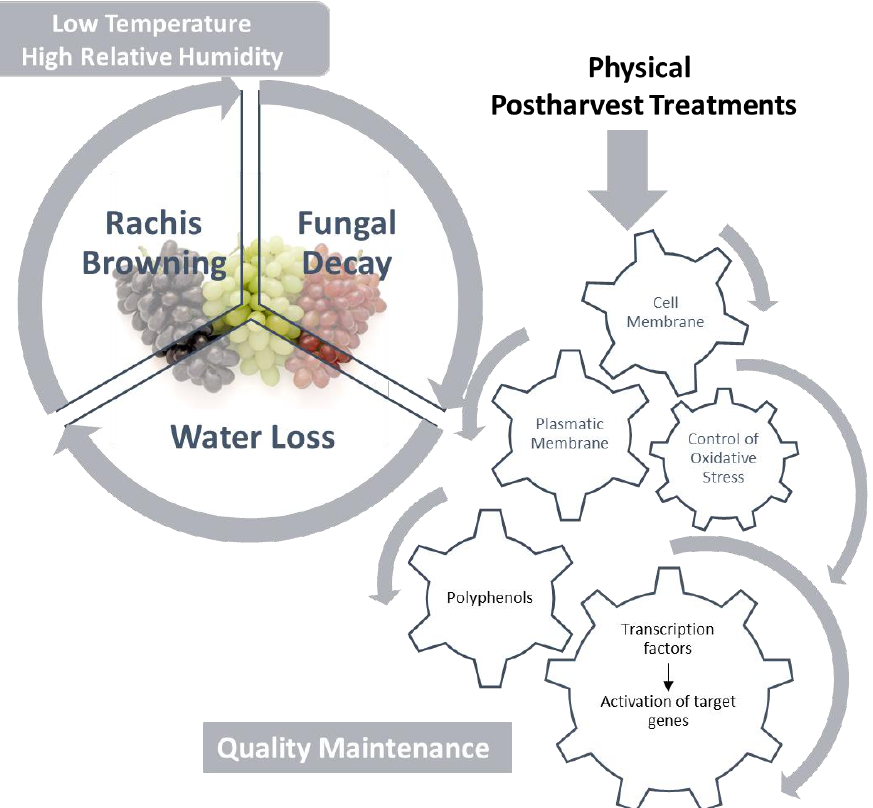
Figure 1. Figure 1. A scheme summarizing responses of table grapes to physical treatments during postharvest storage.